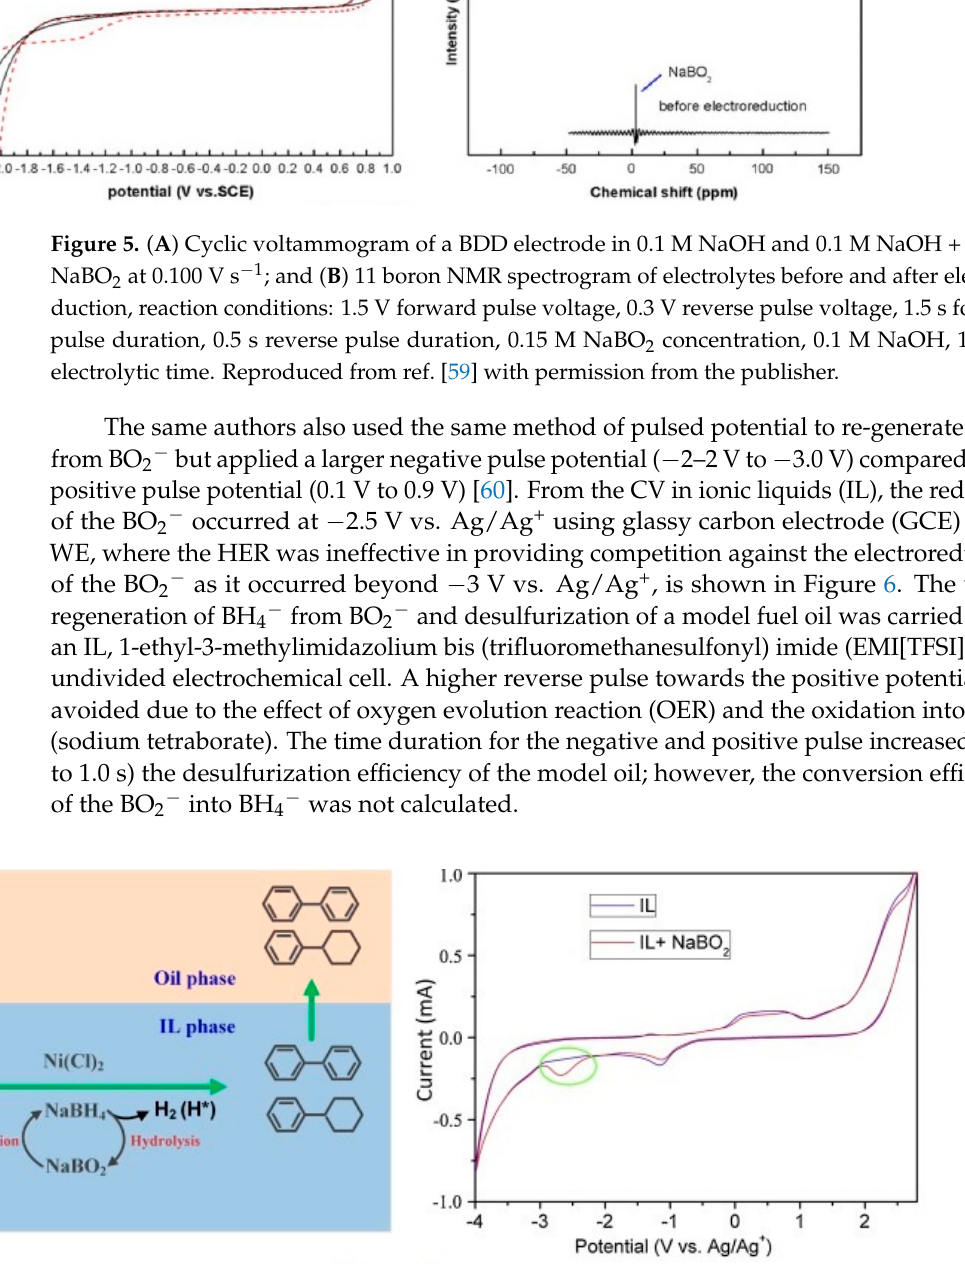
Figure 6. Left : The schematic diagram of the novel desulfurization process. Right : Cyclic voltammogram of IL and IL + NaBO 2 on a glassy carbon electrode at 0.100 V s − 1 . The green arrows show the movement of the molecule. Reproduced from ref. [60] with permission from the publisher.